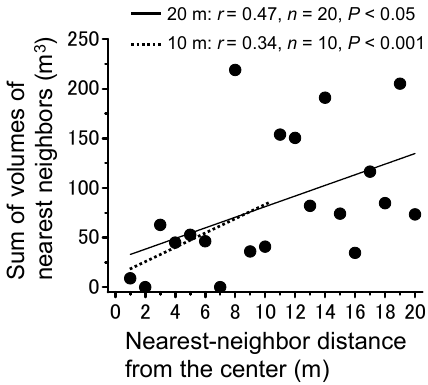
Figure 7. Nearest-neighbor analysis for sum of volumes of individual plants within a local area and distance between nearest neighbor and the center tree where the largest group of roosting locusts aggregated.